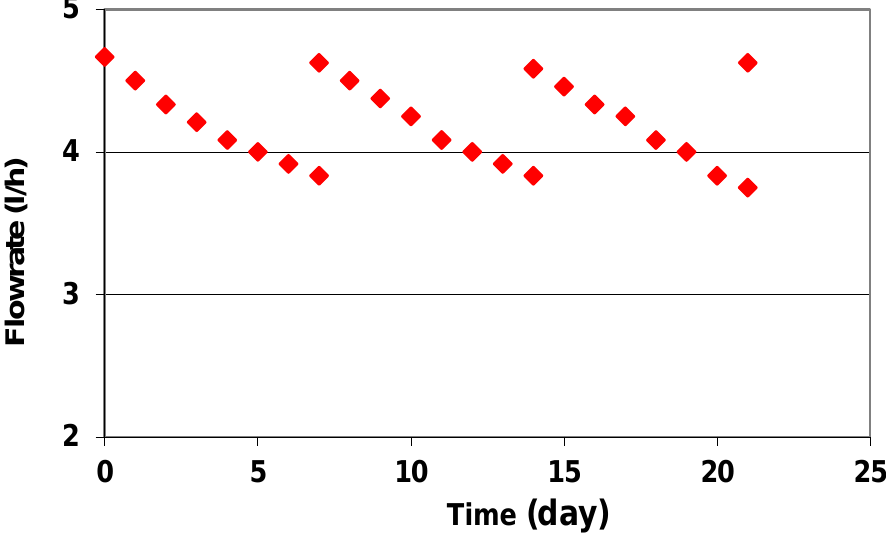
Figure 5. Flowrate reductions over time and subsequent recovery after flushing .